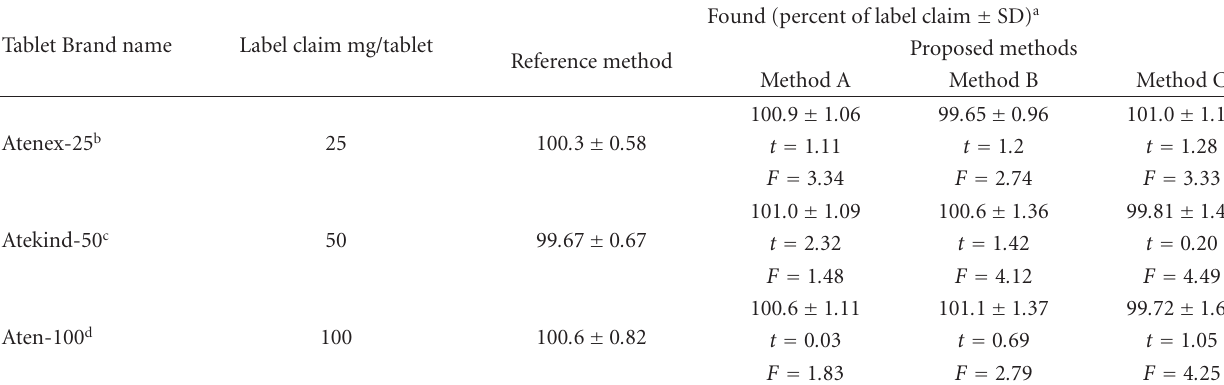
Table 5: Results of analysis of tablets by the reference and proposed